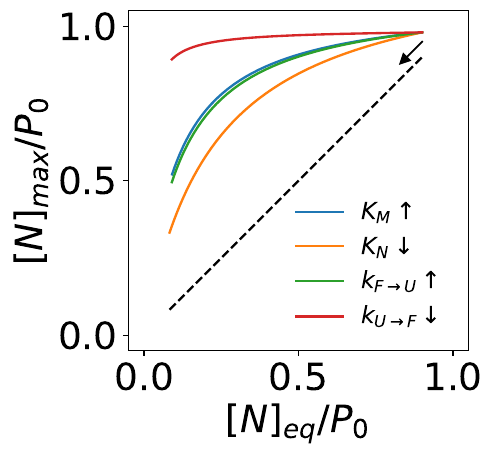
Figure 5. The capacity of ATP-driven chaperones to maintain elevated native fractions in response to destabilizing mutations in a protein substrate. The kinetic parameters of the wild-type protein are K M = 10 2 , K F = 10, K N = 10 2 , k U → F = 0.1 s − 1 , and k a = 10 6 M − 1 · s − 1 ; the concentration of the open chaperone is set to [ O ] = 1